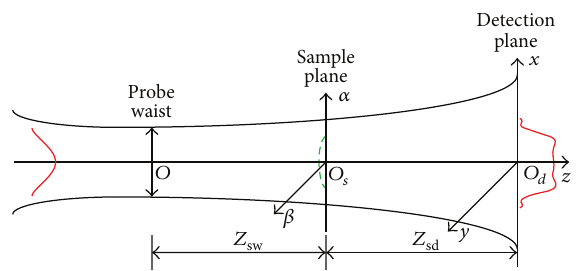
Figure 1: Schematic diagram of stroboscopic surface thermal lensing.